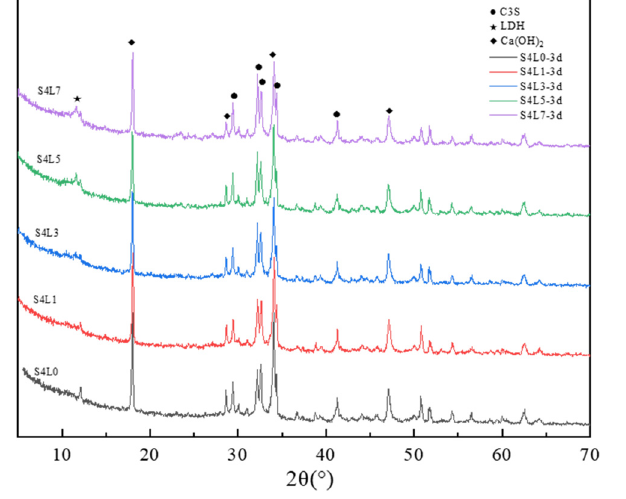
Figure 9: XRD results of the 3 - day - old cement paste samples.